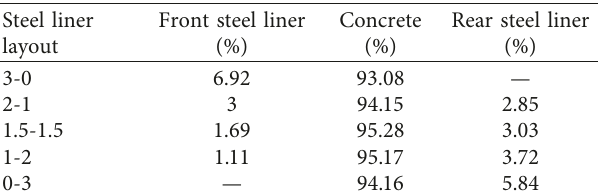
Table 6: Contribution ratio of antiperforation performance with each part of